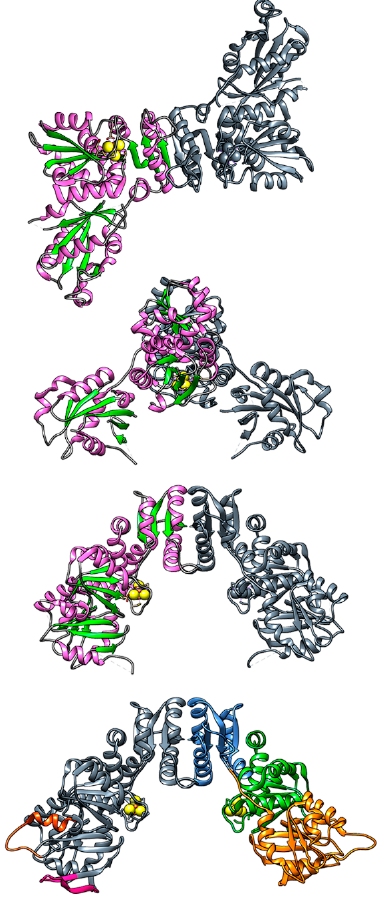
Figure 4. Top, HydF (pdb.id 5KH0) from T. melaniensis viewed from three angles (bottom of the cavity, and two views of the sides rotated 90 ◦ one relative to the other). To highlight the homodimeric assembly of the protein only one monomer has been colored according to secondary structure: in magenta the α -helices, in green the β -strands, the [4Fe-4S] cluster is in sphere representation. Bottom, reconstruction of the whole protein structure in the absence of GTP based on HydF from T. melaniensis (see text) including the missing amino-acid stretches. The left monomer has the reconstructed stretches colored in purple (switch 1 region) and dark orange (switch 2 region). The right monomer has been colored to highlight the three protein domains: GTPase domain in orange, dimerization domain in blue, and cluster-binding domain in green.